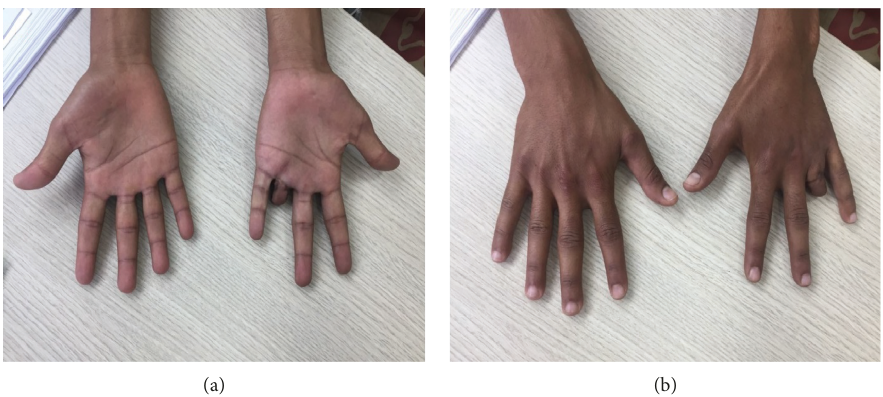
Figure 3: (a, b) Clinical aspect at a follow-up of three months.